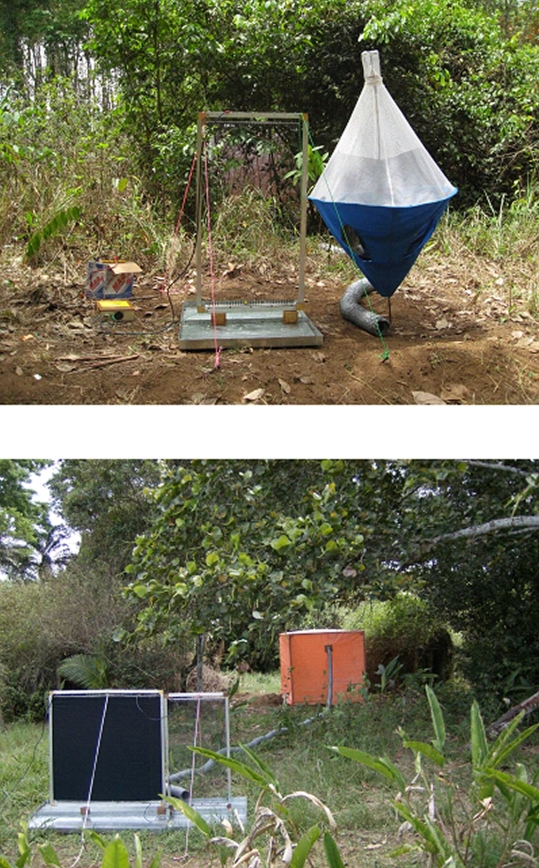
(Top) Biconical trap and (Bottom) E-target with flanking E-nets.The grey pipe leading up to the trap or target carries odour-laden air from a tent, visible in the background, containing live hosts.